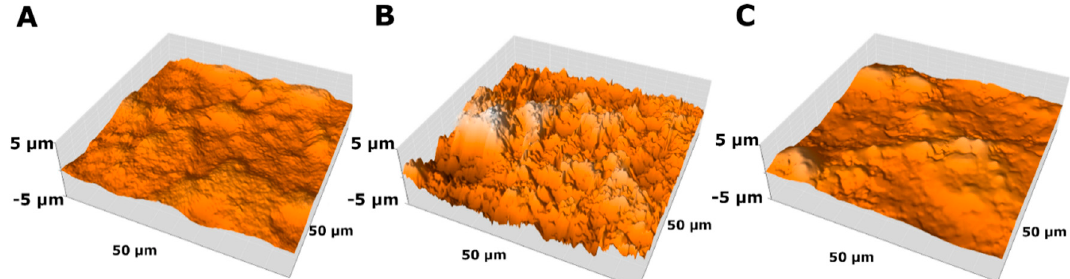
Figure 2. Surface topography based on atomic force microscopy tests for ( A ) the MWCNTs coating, ( B ) the MWCNTs/TiO 2 coating, ( C ) the MWCNTs_Cu coating.